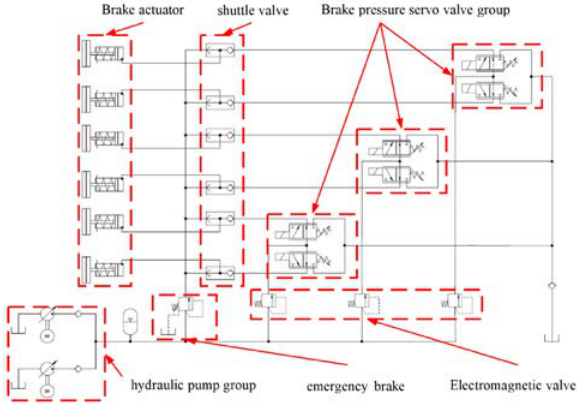
Figure 1. Schematic diagram of the brake servo valve in the hydraulic pipeline system of a large aircraft.